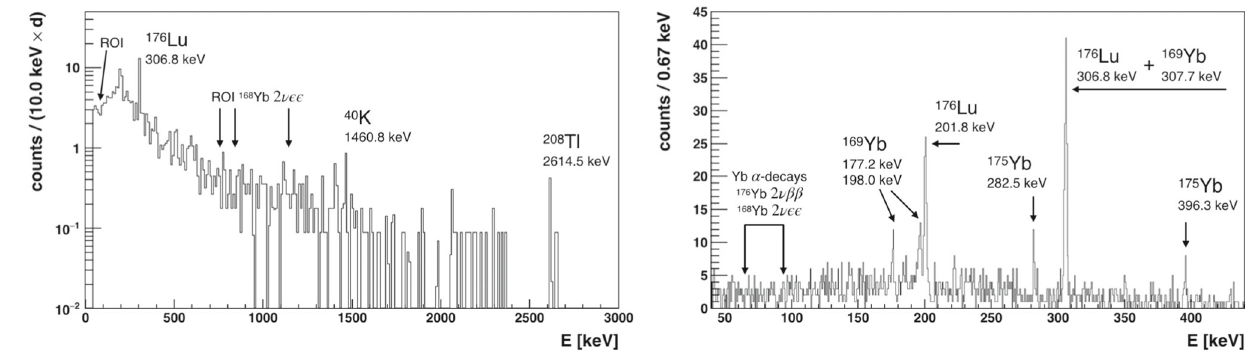
Fig. 3 Measured HPGe spectrum of the 194.7 g Yb 2 (C 2 O 4 ) 3 powder sample obtained in 11.3 days. Left: full spectrum normalized to counts per day. Right: zoom in to the low energy region in original DAQ binning. Prominent background peaks and regions of interest are